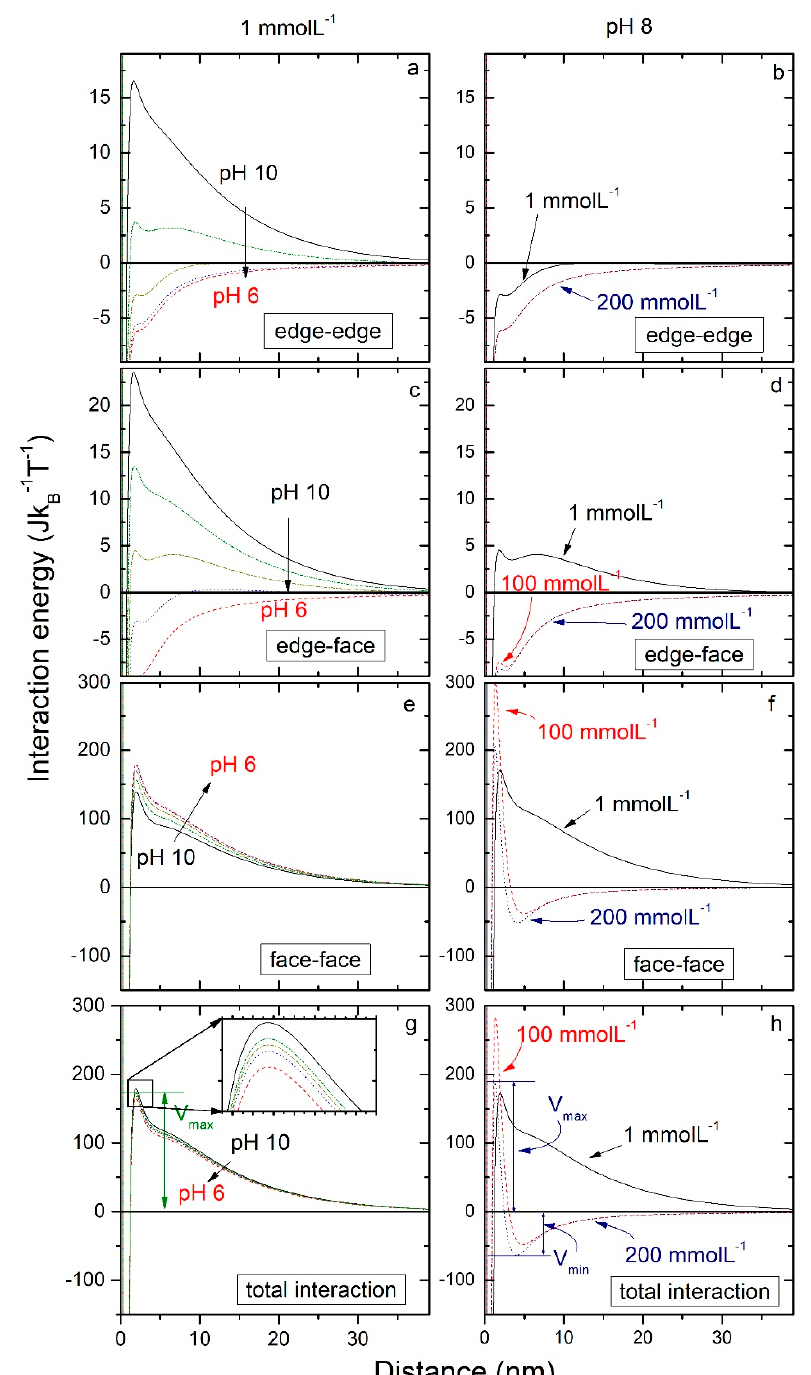
Figure 8. Interaction energy calculated for edge–edge ( a , b ), edge–face ( c , d ), face–face ( e , f ), and total ( g , h ) interaction for FEBEX bentonite colloids and 1 mmol L − 1 NaCl electrolyte solution as a function of pH (left) and different background electrolyte concentrations at pH 8 (right) for the best fit surface potentials (see Figure 6b) and the edge electrokinetic potential calculated with α -alumina (see Figure 7a).